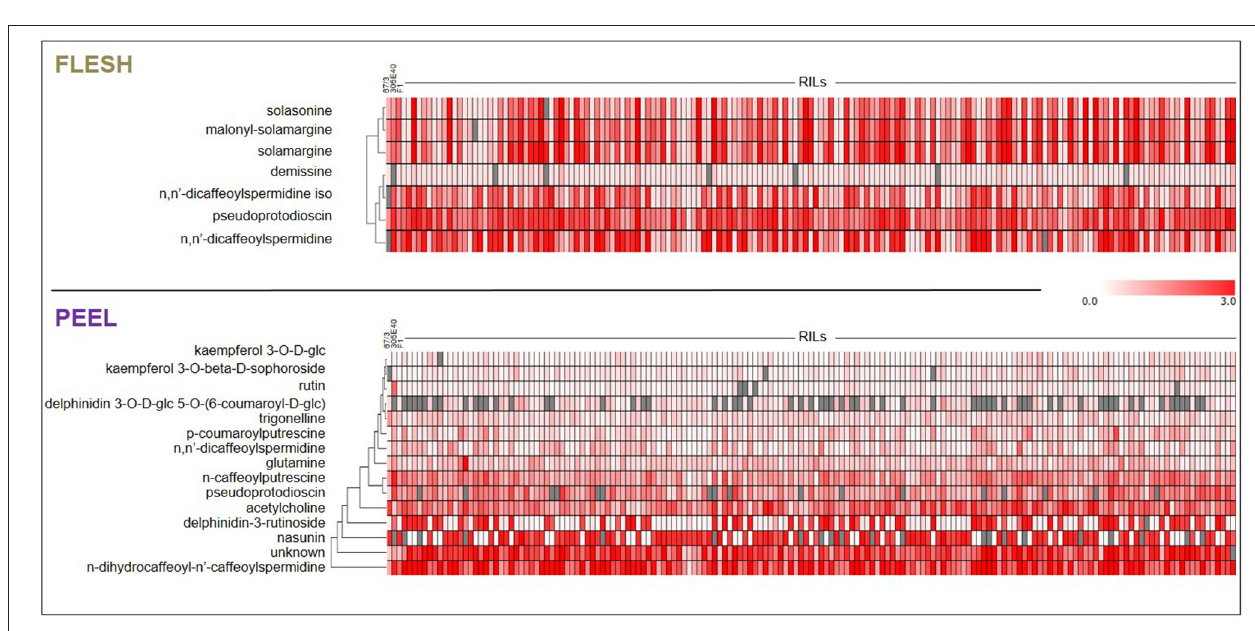
et al., 2008) or influencing nutritional quality in tomato fruits (Schauer et al., 2006) and potato tubers (Carreno- Quintero et al., 2012). With respect to other Solanaceae,